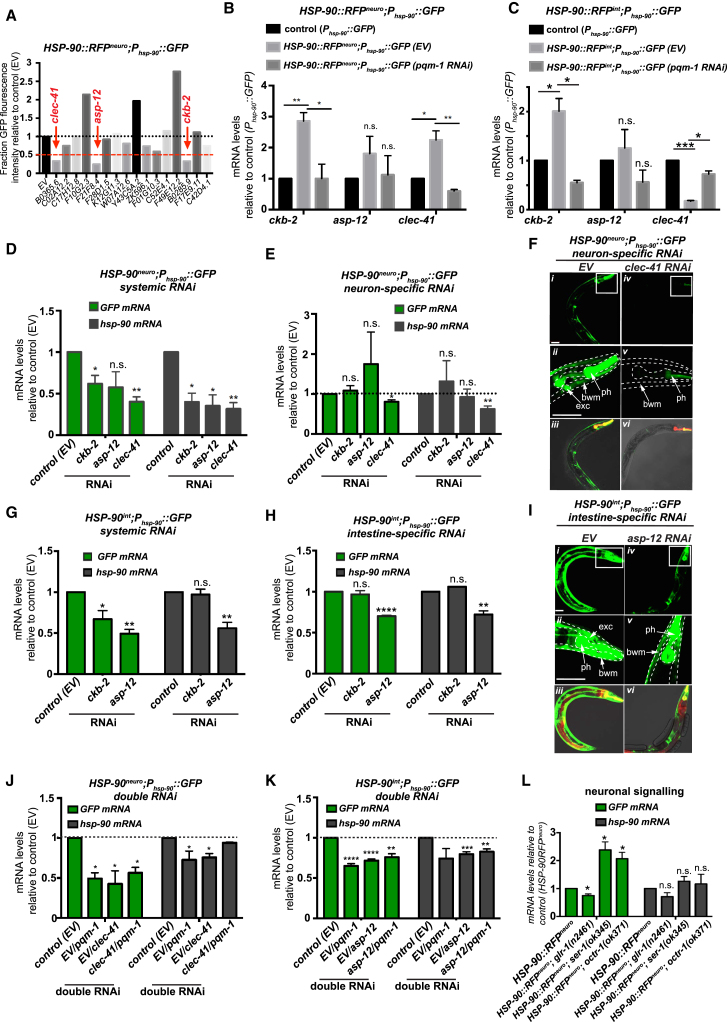
pqm-1-Regulated Genes Are Required for TCS-Induced hsp-90 Expression(A) Quantification of Phsp-90::GFP fluorescence intensity in HSP-90::RFPneuro;Phsp-90::GFP animals during RNAi-mediated knockdown of indicated 16 genes relative to control (EV) RNAi. Scored hits (clec-41, asp-12, and ckb-2) show less than 50% GFP fluorescence intensity.(B) mRNA levels of ckb-2 (B0285.9) and innate immune factors asp-12 (F21F8.4) and clec-41 (B0354.5) in HSP-90neuro;Phsp-90::GFP animals treated with control or pqm-1 RNAi.(C) Total mRNA levels of pqm-1-regulated kinase ckb-2 (B0285.9) and innate immune factors asp-12 (F21F8.4) and clec-41 (B0354.5) in HSP-90int;Phsp-90::GFP animals treated with control or pqm-1 RNAi.(D) Whole-animal (systemic) RNAi knockdown of ckb-2, asp-12, or clec-41 in HSP-90neuro;Phsp-90::GFP reduces transcript levels of GFP and hsp-90.(E) Neuron-specific RNAi of clec-41, but not ckb-2 or asp-12, reduces GFP and hsp-90 mRNA levels in HSP-90neuro;Phsp-90::GFP;sid-1(pk3321);unc-119p::SID-1.(F) Collapsed z stack images of HSP-90::RFPneuro;Phsp-90::GFP;sid-1(pk3321);unc-119p::SID-1 animals allowing for neuron-specific EV control RNAi (i) or clec-41 RNAi (iv). 20x magnification of the anterior (head) region (ii and v). Differential interference contrast (DIC) Nomarski GFP, RFP overlay images (iii and vi).(G) Whole-animal (systemic) RNAi knockdown of ckb-2 and asp-12 in HSP-90int;Phsp-90::GFP reduces GFP and hsp-90 mRNA levels.(H) Intestine-specific RNAi of asp-12, but not ckb-2, reduces GFP and hsp-90 mRNA levels in HSP-90int;Phsp-90::GFP sid-1(pk3321);vha-6p::SID-1.(I) Collapsed z stack images of HSP-90::RFPint;Phsp-90::GFP;sid-1(pk3321);vha-6p::SID-1 animals allowing for intestine-specific control RNAi (i) or asp-12 RNAi (iv). 20x magnification of the anterior (head) region (ii and v). Differential interference contrast (DIC) Nomarski images (iii and vi).(J) Simultaneous pqm-1 and clec-41 RNAi (1:1 ratio) does not further reduce GFP mRNA and hsp-90 mRNA levels in HSP-90neuro;Phsp-90::GFP.(K) Simultaneous pqm-1 and asp-12 RNAi (1:1 ratio) does not further reduce GFP mRNA and hsp-90 mRNA levels in HSP-90int;Phsp-90::GFP.(L) GFP and hsp-90 transcript levels in HSP-90::RFPneuro; Phsp-90::GFP animals crossed into the genetic background of glr-1(n2461), ser-1(ok345), or octr-1(ok371) mutants relative to control animals.Bar graphs represent combined mean values of three independent experiments (B–E, G, H, J, K, and L). Error bars represent ± SEM. ∗∗∗∗p < 0.0001; ∗∗p < 0.01; ∗p < 0.05; ns, not significant.See also Figure S7.